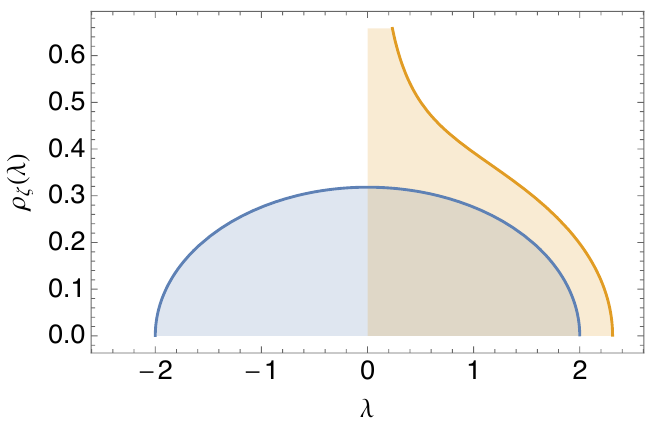
Figure 1 . Gaussian ensemble spectra: in blue: typical spectrum, following the semi-circle law of eq. (2.4). Yellow: (cid:13)uctuated spectrum with all eigenvalues positive, following the distribution law of eq. (2.5) with (cid:16) =